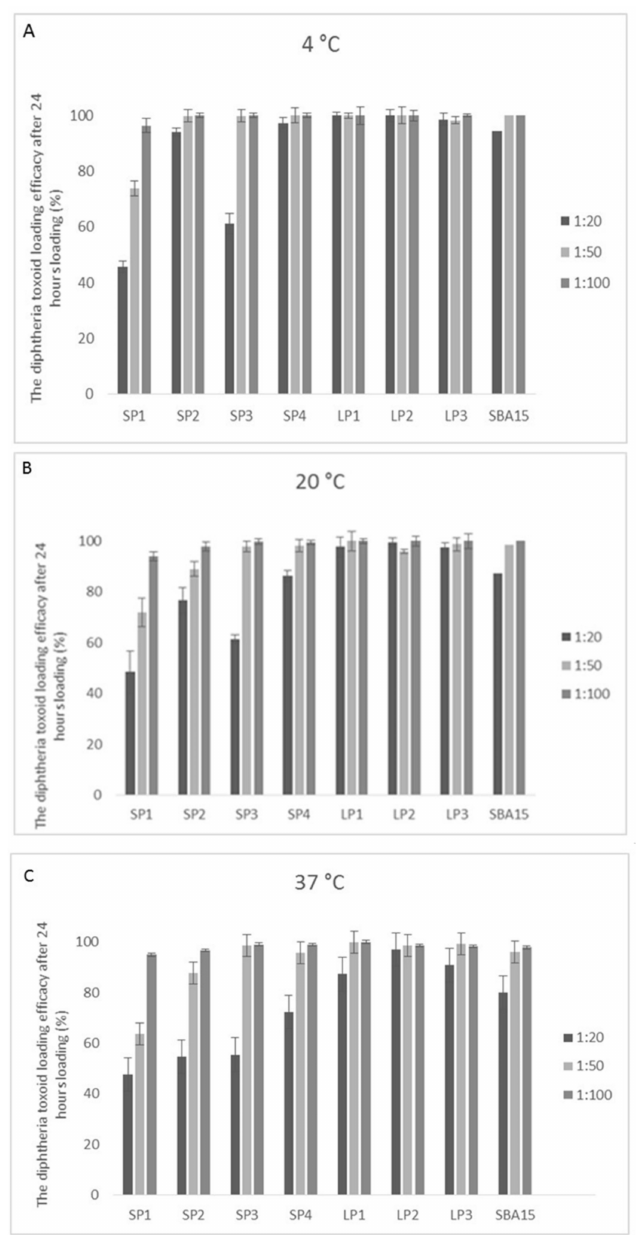
Figure 3. Antigen loading onto the MSNPs. Diphtheria toxoid was incubated with the di ff erent MSNPs for 24 hours at either ( A ) 4 ◦ C; ( B ) 20 ◦ C; ( C ) 37 ◦ C. The toxoid to MSNP ratio was varied from 1:20, 1:50, and 1:100. Data shown is mean ± standard deviation. Three independent experiments were performed with triplicate samples, and data from all experiments